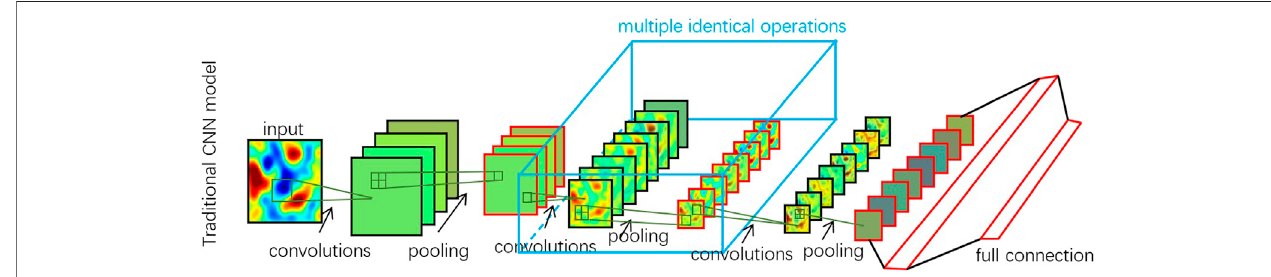
FIGURE 1 | Traditional CNN model.